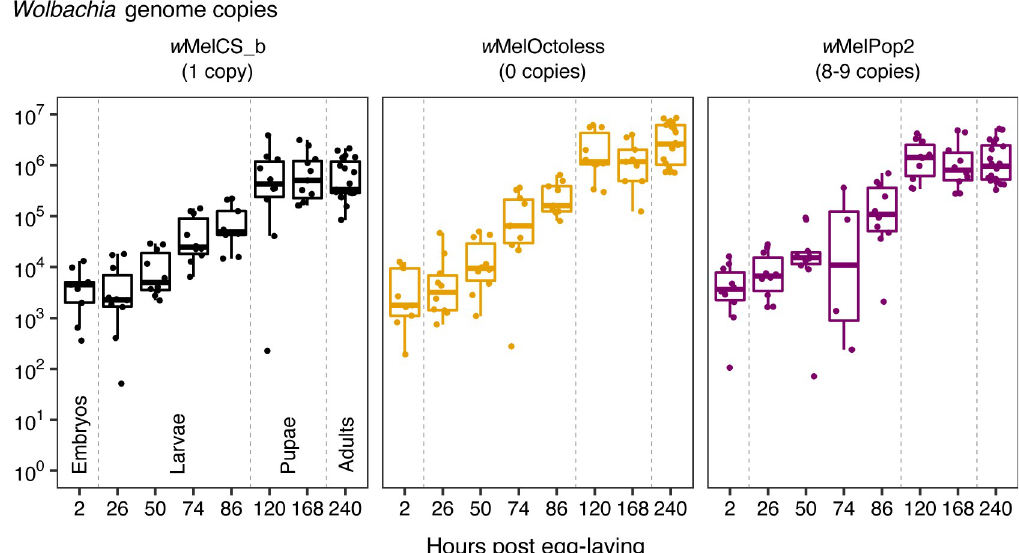
Fig 4. Wolbachia proliferates rapidly during larval development. Wolbachia genome copies throughout D . melanogaster development. Samples are embryos (2h), 1 st instar larvae (26h), 2 nd instar larvae (50h), 3 rd instar larvae (74h and 86h), white prepupae (120h), P8 staged pupae (168h), and newly eclosed adults (240h). Vertical dashed lines separate developmental stages (i.e. eggs, larvae, pupae, and adults). Dots represent either a pool of 10 individuals (embryos and larvae) or a single individual (pupae and adults). The x-axis is not in a continuous scale. Proliferation of the different Wolbachia variants in the first 120 hours was analysed using an exponential model. A summary is given in Table 1.